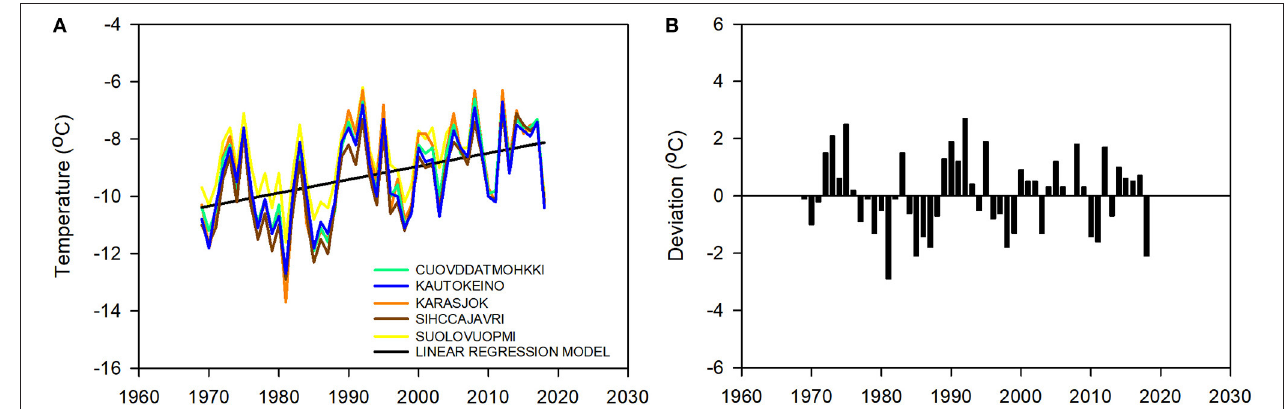
FIGURE 9 | Winter warming. (A) Mean annual ambient temperature (October to April, O-A) and linear trend in temperature ( ◦ C) over the reindeer winter pasture area of Finnmarksvidda ( Figure 7 ), 1969–2018. Data from five weather stations: Cuovddatmohkki, Karasjok, Kautokeino, Sihccajavri and Suolovuopmi ( Figure 7 ). The